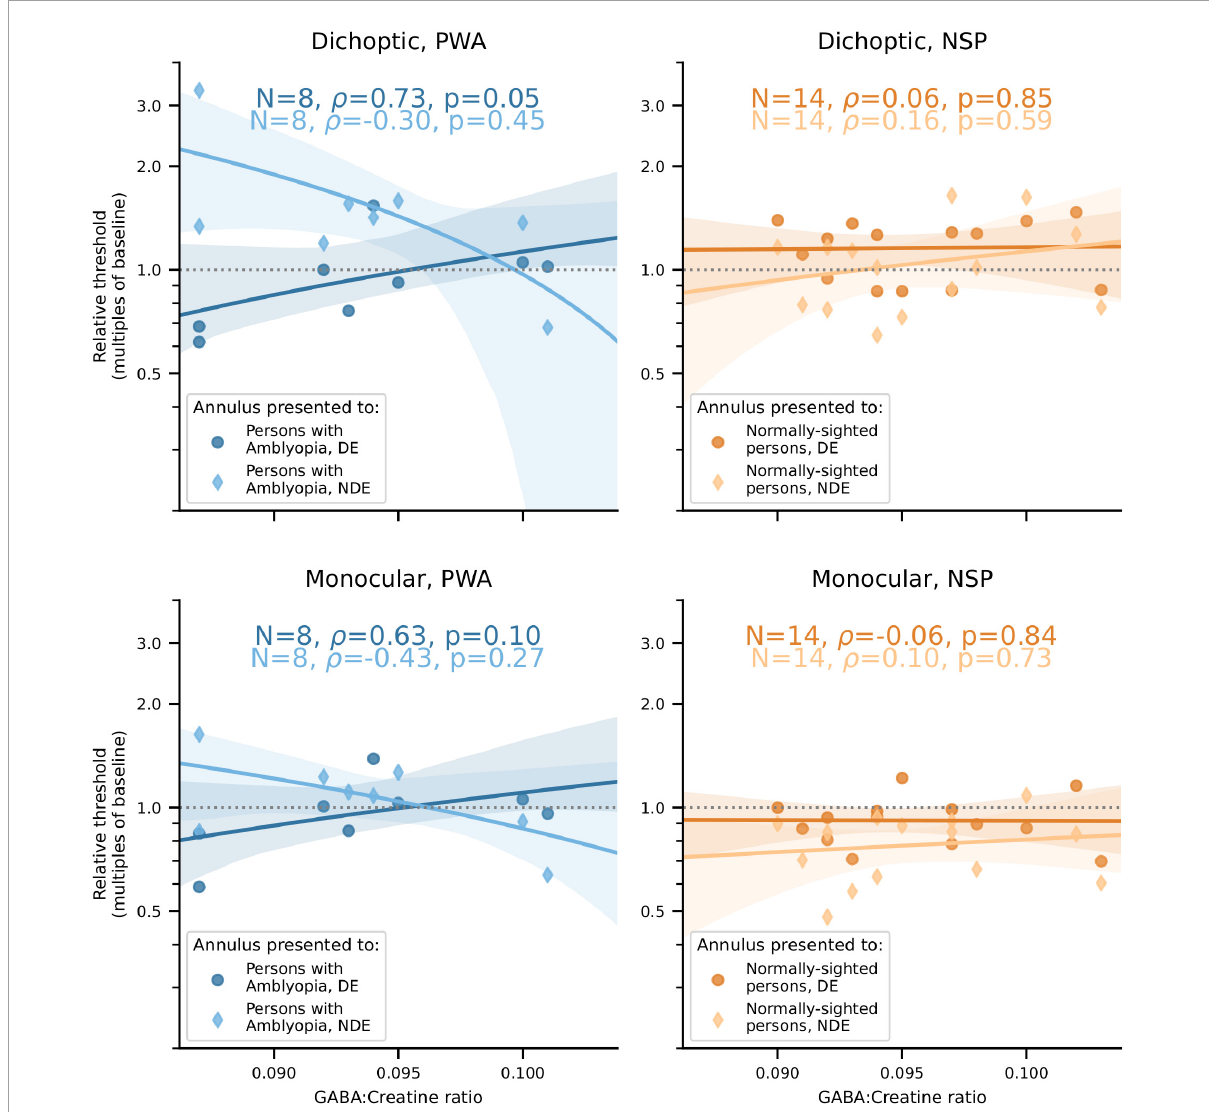
FIGURE4 Relationships between cross-oriented surround suppression ( Figure 2C ) and visual cortical GABA levels. Top row: Dichoptic presentation. Bottom row: Monocular presentation. Left column: PWA. Right column: NSP. Shading indicates 95% bootstrapped confidence intervals of the best linear fit. The difference in the strength of the GABA/surround suppression correlation between the two eyes of PWA was significant for monocular ( p = 0.04) and dichoptic ( p = 0.048)